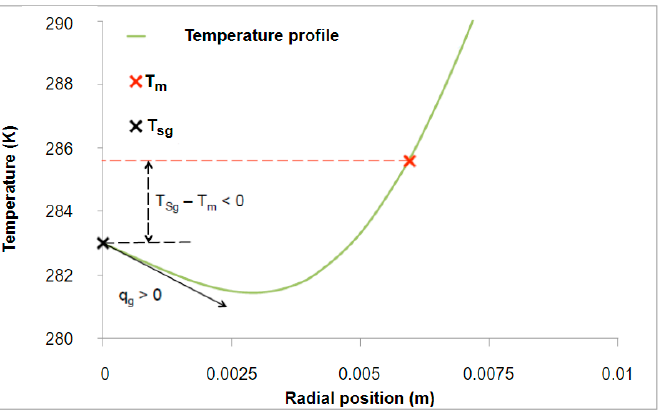
Figure 7. Temperature profile in the air gap [35]. Reprinted with permission from Ref. [35]. Copyright 2014 Gloriant, F.A.F. All rights reserved.